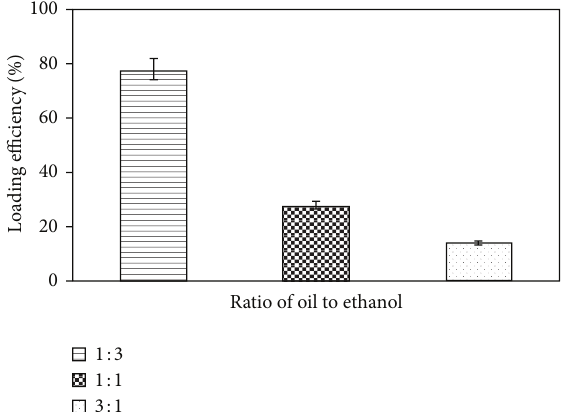
Figure 7: Effect of oil to ethanol volume (oil:ethanol) on loading efficiency of curcumin onto starch nanoparticles.